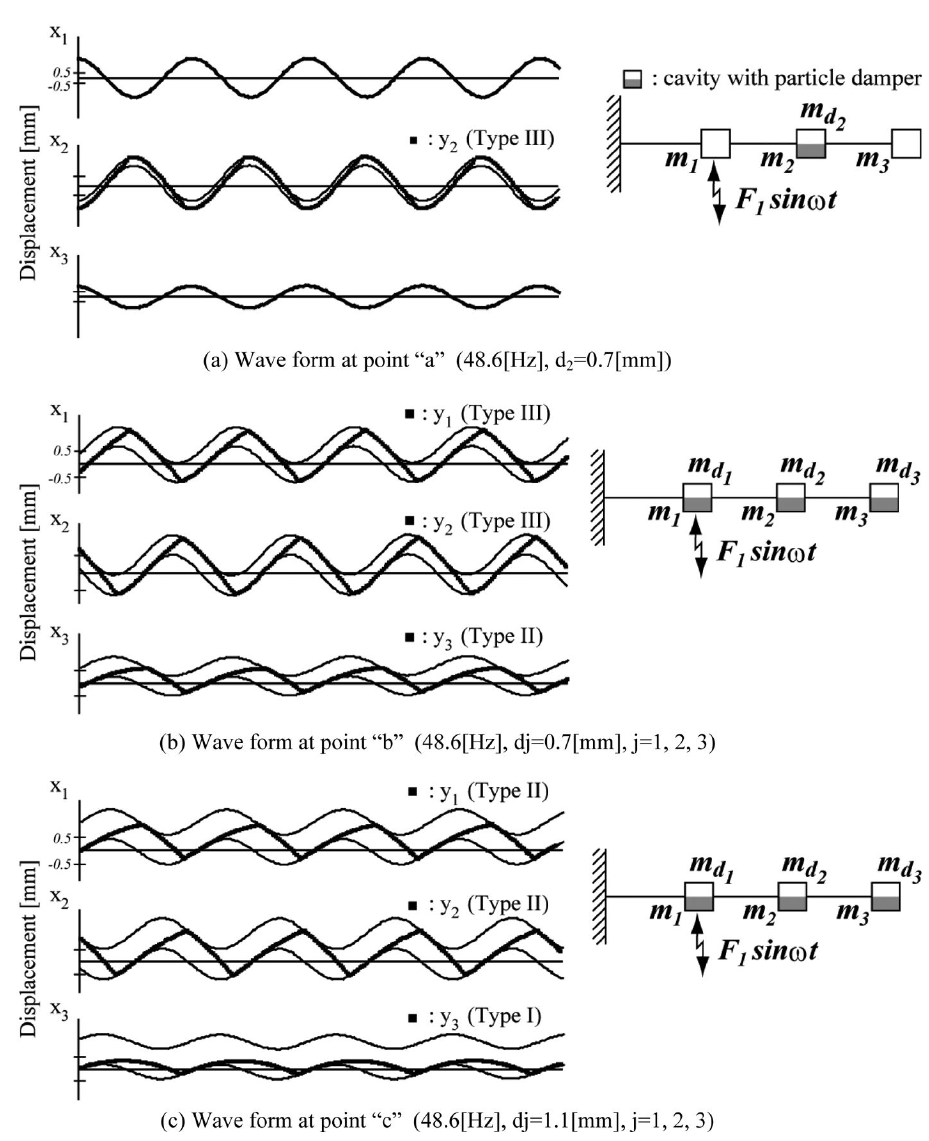
Fig. 6. Type of impact vibration of MDOF system.